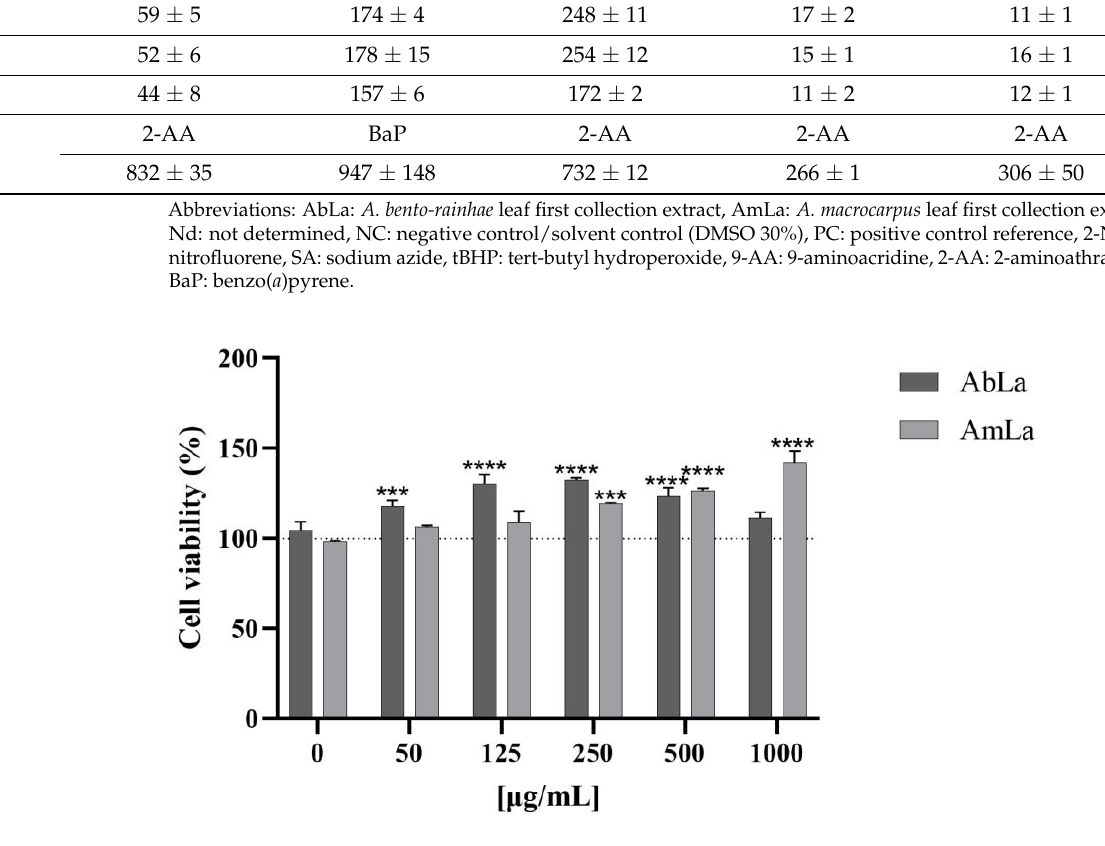
Figure 3. HepG2 viability after 48 h of incubation with AbLa and AmLa extracts evaluated by MTT reduction assay. Data are shown as the percentage of solvent control (dashed line) and as mean ± standard deviation; n = 2–5. *** p < 0.001; **** p < 0.0001.